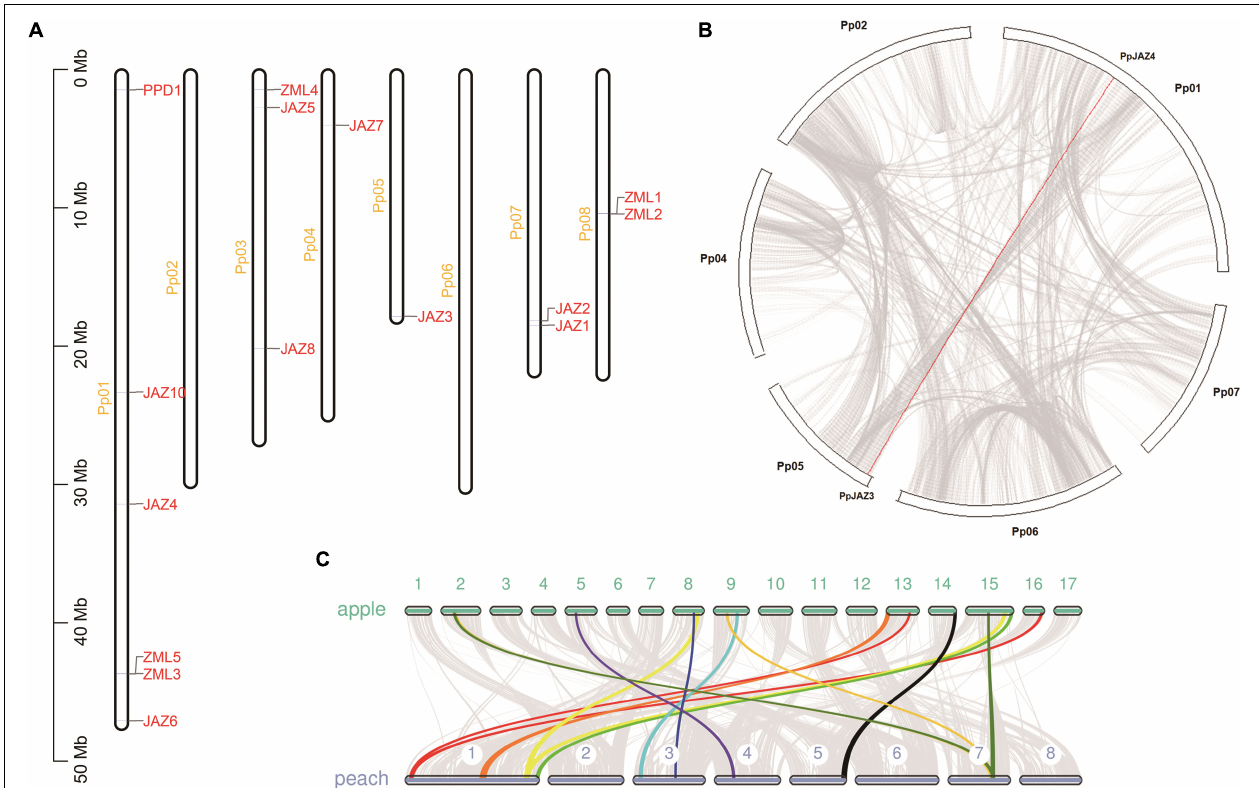
FIGURE 1 | Genomic analysis of peach JAZ , PPD and ZML genes. (A) Genomic distribution of the JAZ , PPD and ZML genes in the peach genome v2.0 (Verde et al., 2017). The white bars represent peach chromosomes; (B) Collinearity analysis of the JAZ , PPD , and ZML members in the peach genome v2.0. The red line represents the segmentally duplicated pair, PpJAZ3 / 4 ; (C) Large-scale synteny comparison between peach genome v2.0 and apple genome v1.0 (Velasco et al., 2010). Colored bands represent the synteny regions comprising the peach JAZ , PPD or ZML